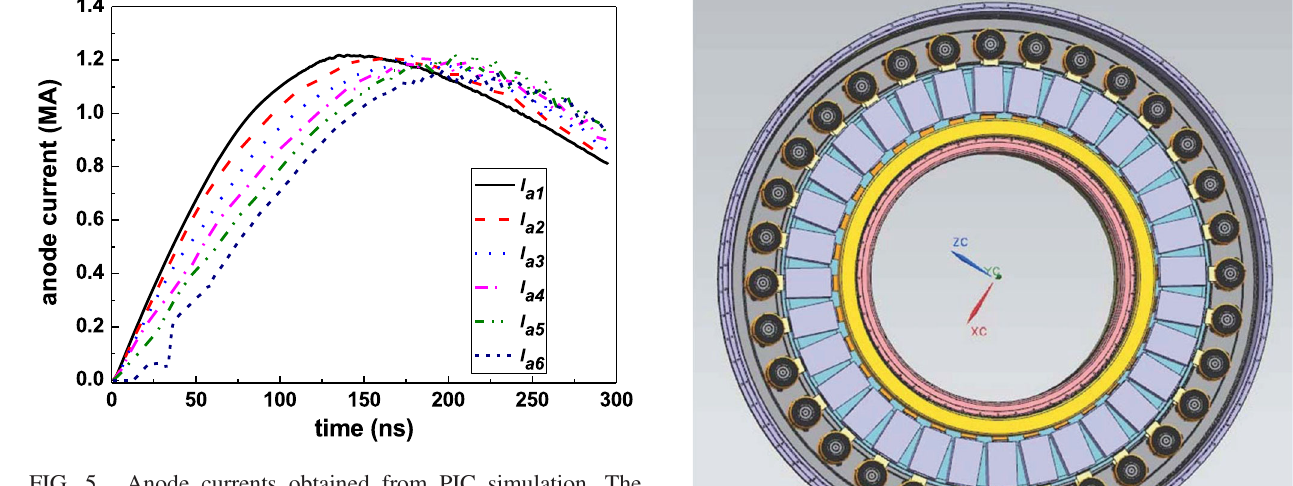
FIG. 5. Anode currents obtained from PIC simulation. The currents were observed at anode after each LTD group and after the final conical line for a self-limited magnetic insulation. The maximum current after each group was above 1.1 MA, slightly higher than the designed value. The almost constant anode current indicated magnetic insulation was well maintained.